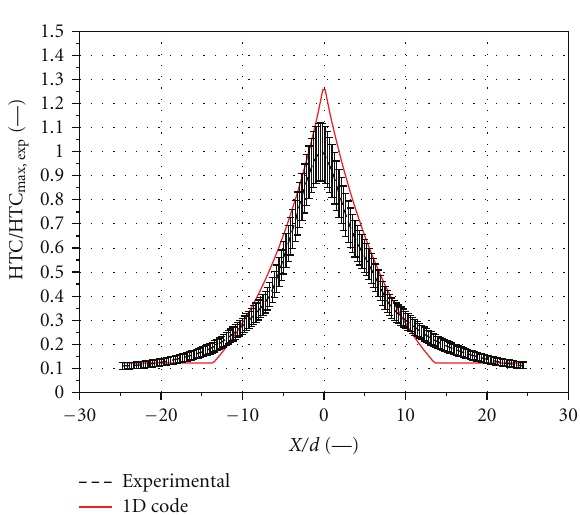
Figure 7: Heat transfer coe ffi cient distribution, central hole of the array, Geom 1 β = 1 . 15 (experimental data from Facchini et al. [14]).